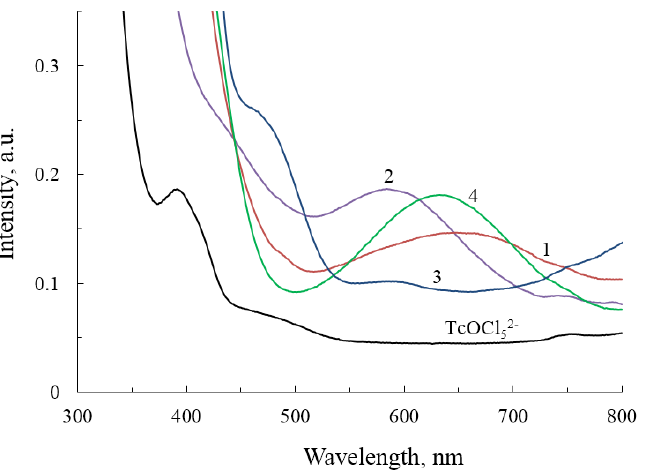
Figure 6. Electron absorption spectroscopy of mother methanol solutions of complexes: Compound 1 − curve 1; compound 2 − curve 2; compound 3 − curve 3; compound 4 − curve 4; and stock solution (NH 4 ) 2 TcOCl 5 . The concentration of technetium in the solutions was equal and amounted to approximately 0.01 M.